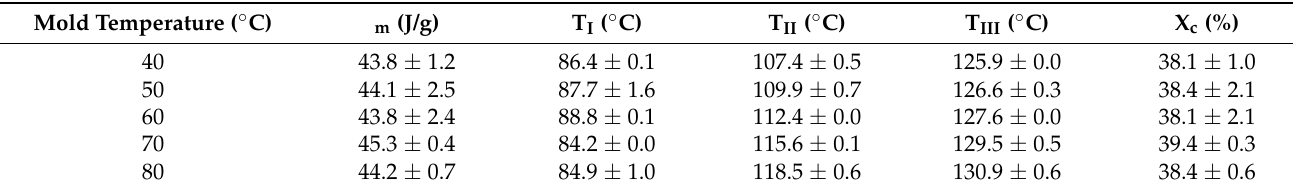
Figure 6. DSC first heating curves of PHBHHx samples with variable mold temperatures M = 40 to 80 °C with three endothermal peaks (I–III) for crystallinity calculations. Table 10. Melting peak enthalpy ( ∆ H m = ∆ H m,I + ∆ H m,II + ∆ H m,III ), endothermal peak temperatures (T I , T II , and T III ) and percentage crystallinity (X c ) determined with DSC at 20 °C/min for mold temperatures M ranging from 40 °C to 80 °C ( n = 2, ±1 SD).